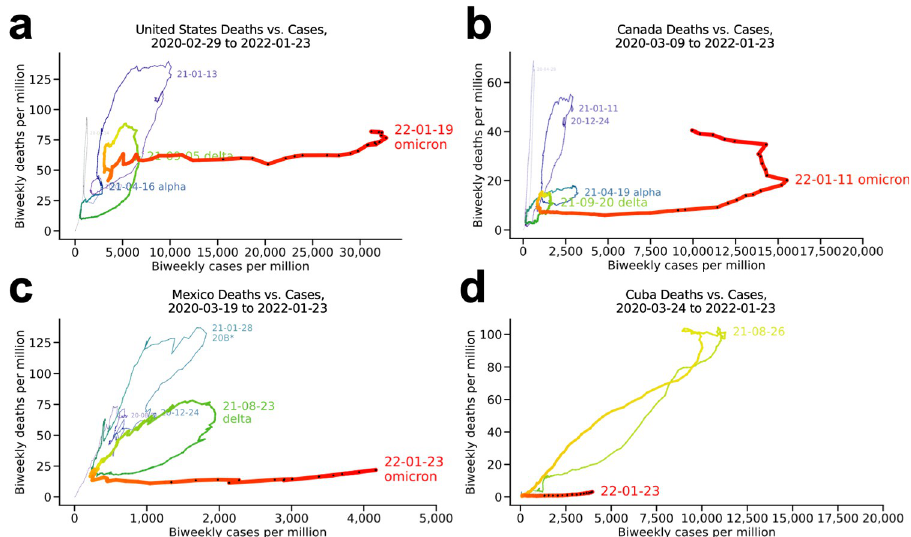
Fig 7. North America. (a) United States, (b) Canada, (c) Mexico, where variant � 20B accounted for 47% of reported strains in the January 2021 case peak, and (d) Cuba.